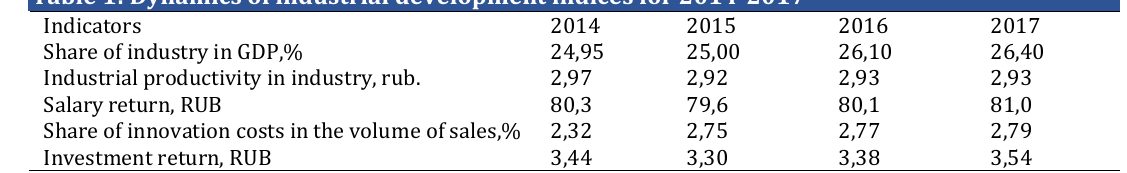
Table 1: Dynamics of industrial development indices for 2014-2017